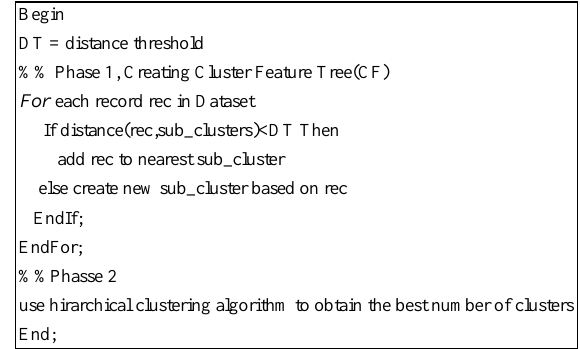
Figure 3. Two-step clustering algorithm